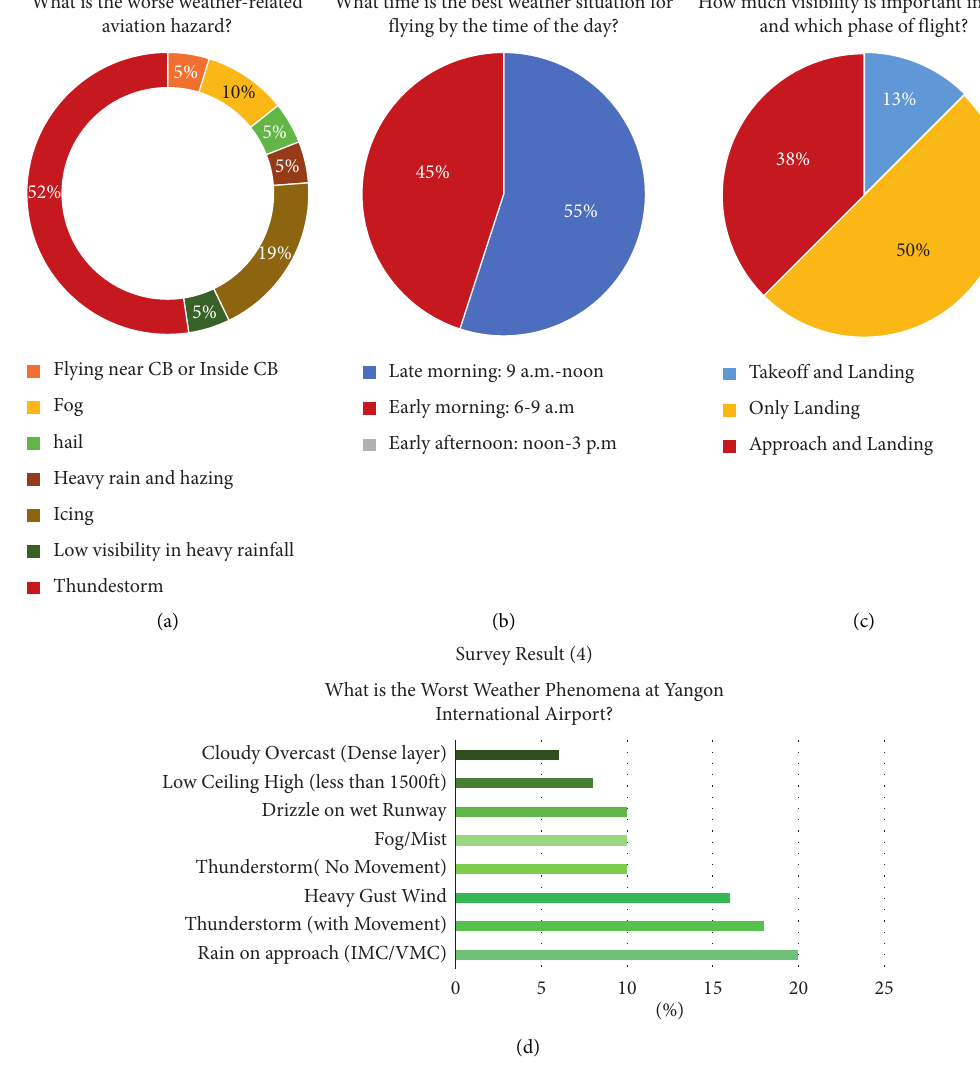
Figure 7: Questionnaires survey results.